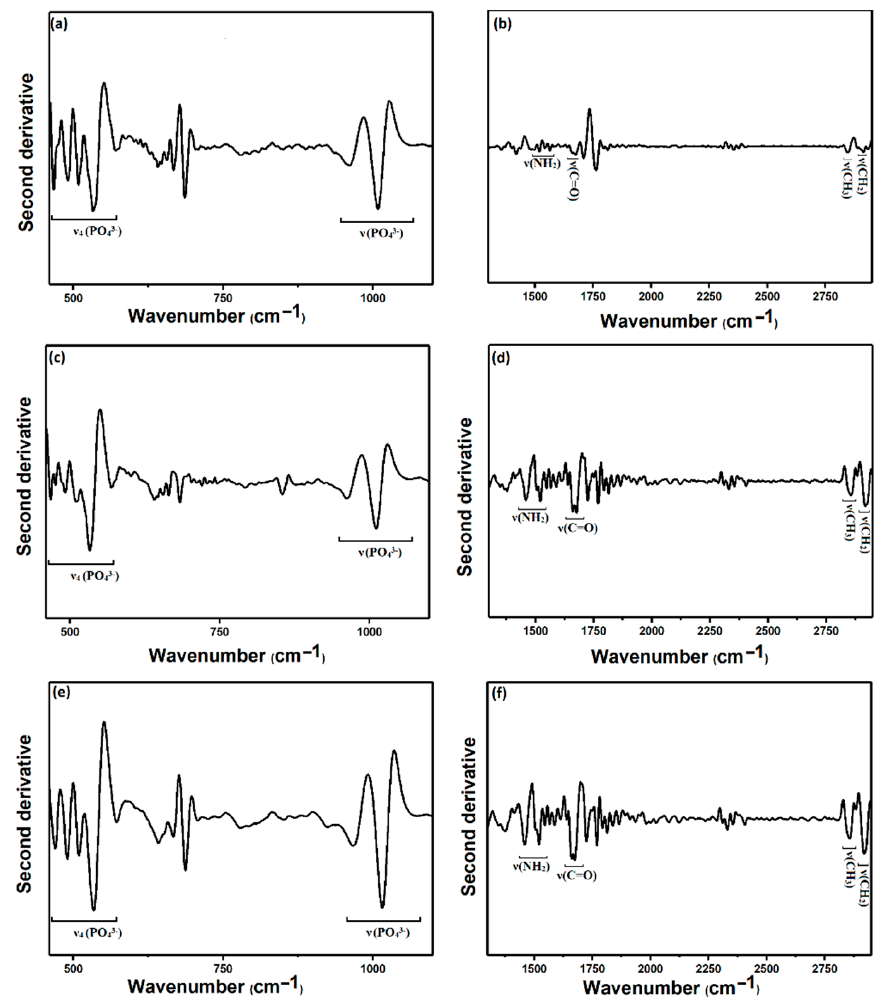
Figure 2. Second derivative spectra of CS–HAp coatings obtained at: p = 2 × 10 − 3 mbar ( a , b ); p = 5 × 10 − 3 mbar ( c , d ); p = 1.2 × 10 − 2 mbar ( e , f ).